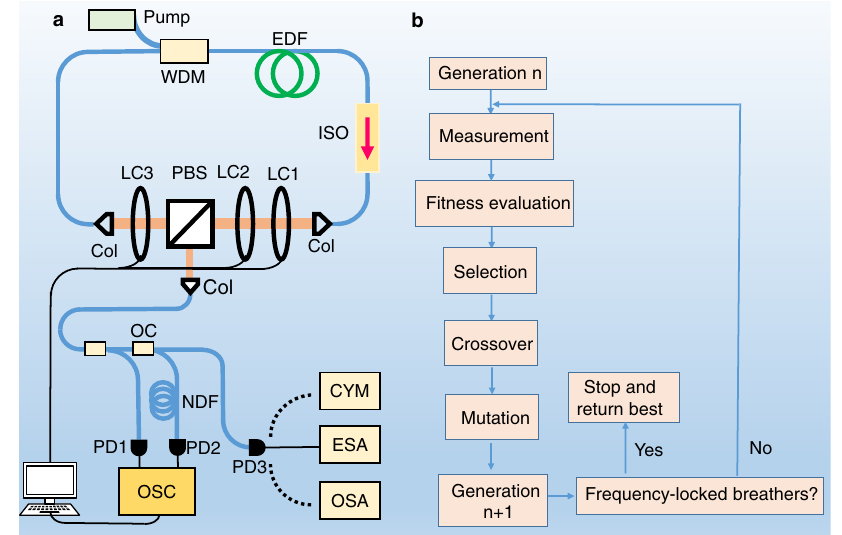
Fig. 1 | The experimental con fi guration. a The breather fi bre laser setup. WDM wavelength-division multiplexer, EDF erbium-doped fi bre, ISO isolator, LC liquid crystal phase retarder, PBS polarisation beam splitter, Col collimator, OC optical coupler, NDF normally dispersive single-mode fi bre involved in the dispersive